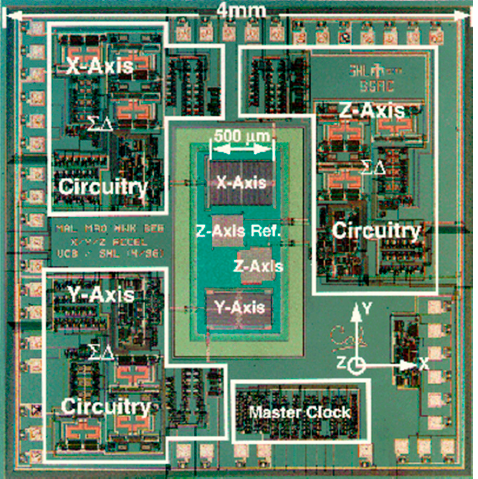
Figure 2. Die photo of a 3-axis accelerometer implemented by iMEMS processes [13].